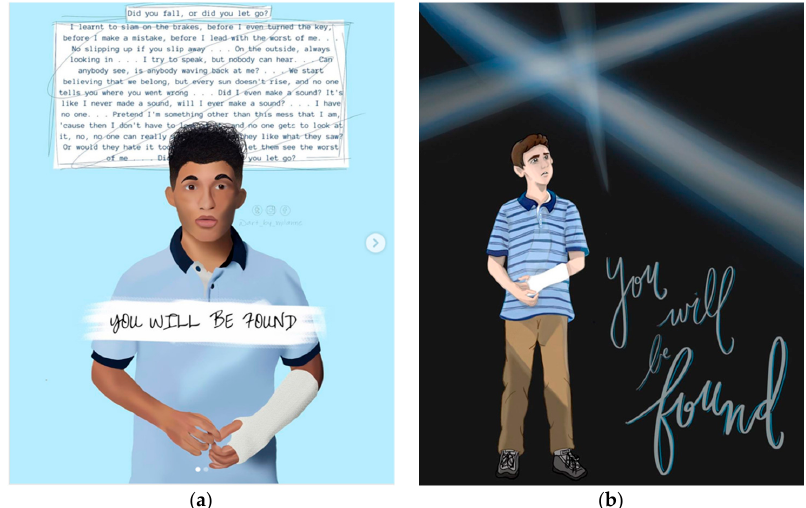
Figure 1. ( a ) Digital artwork depicting Jordan Fisher as Evan Hansen accompanied by popular lyrics ‘You Will Be Found’. Used with permission from @art_by_milanne on Instagram (2020). ( b ) Another piece of digital artwork depicting a varying interpretation of Evan Hansen accompanied by the popular phrase. Used with permission from @heylynndraws on Instagram (2020).